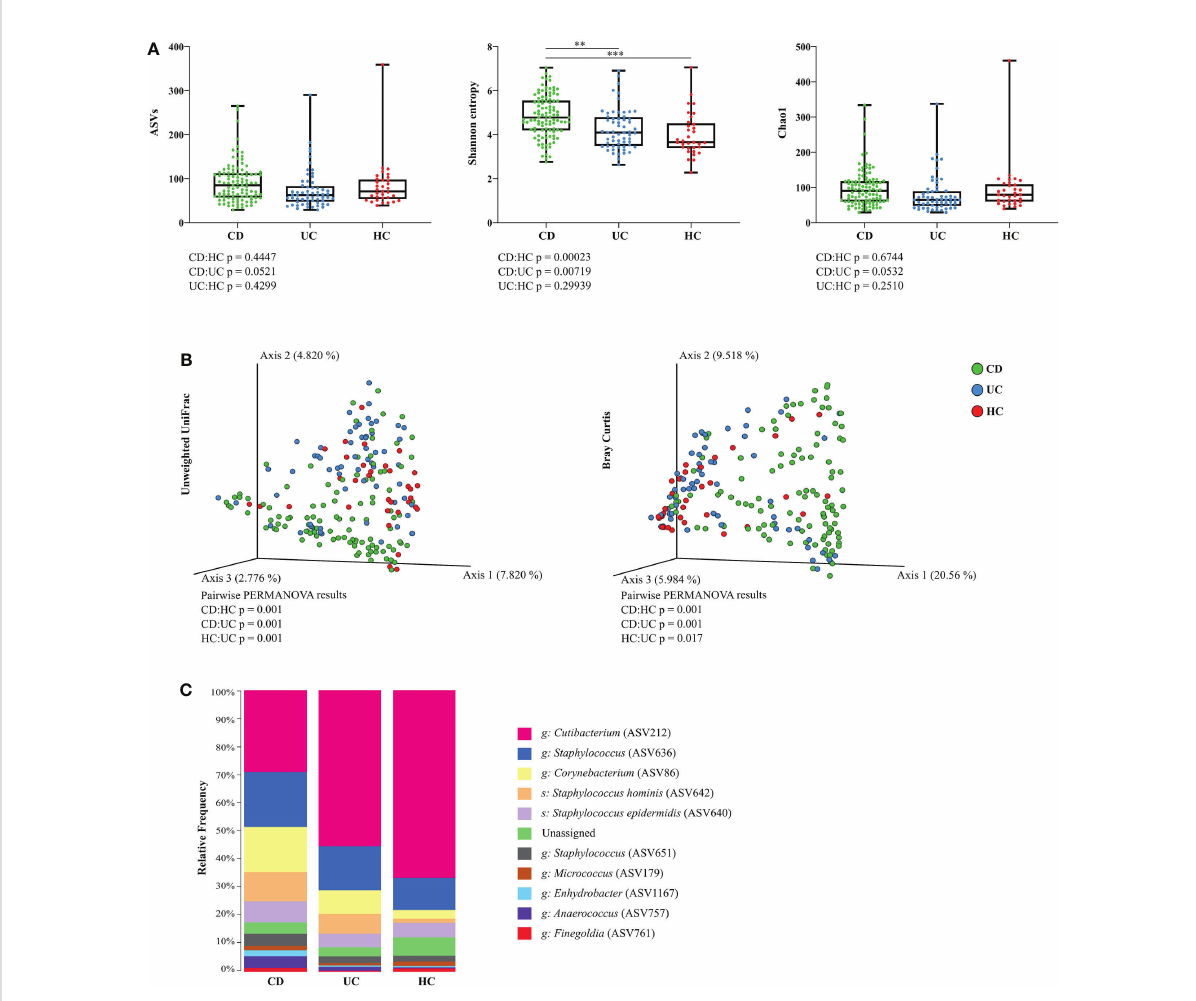
FIGURE 1 Skin microbiota diversity differs between CD, UC, and HC at the retroauricular crease. (A) Comparison of alpha diversity indices between CD, UC, and HC. Each point represents one sample. The differences were analyzed by Linear mixed effect models (LMM) and subsequent Tukey post hoc test. (B) Principal coordinate analysis of the Bray-Curtis distance between CD, UC, and HC. Each point represents one sample. Groups were compared by PERMANOVA. (C) Relative abundance of the top 10 most abundant taxa of skin microbiota at the genus and species level. In all panels: **p<0.01; ***p<0.001. ASVs, amplicon sequence variants; CD, Crohn ’ s disease; UC, ulcerative colitis; HC, healthy